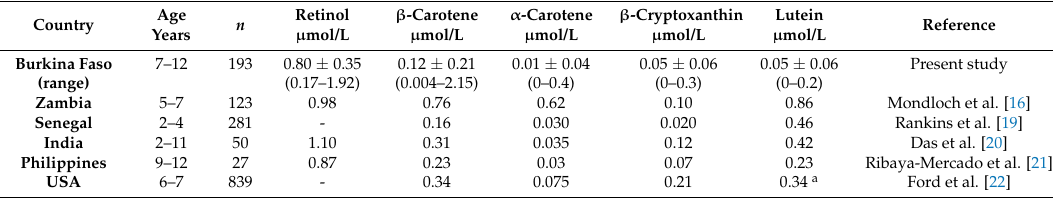
Table 2. Serum carotenoids concentrations ( ± SD) or range in apparently healthy children from various regions of the